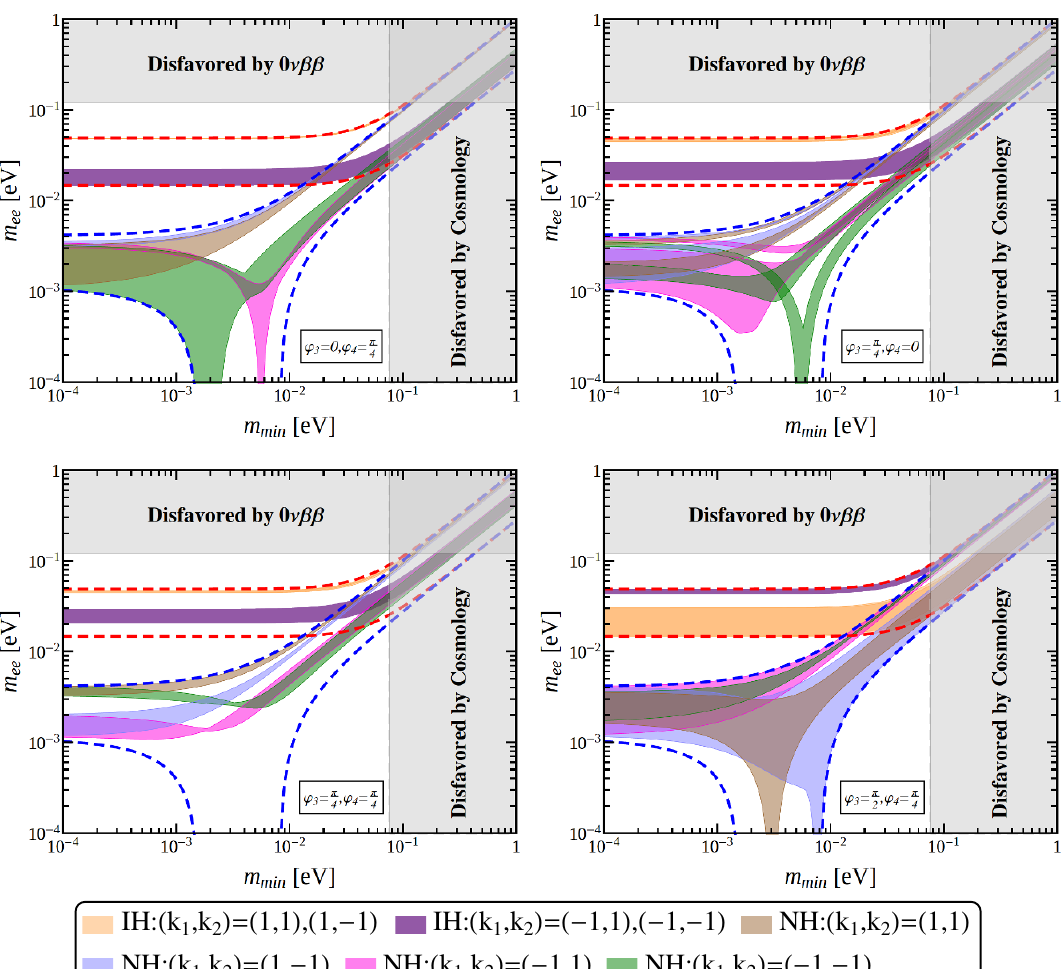
Figure 9 . The possible values of the e(cid:11)ective Majorana mass m ee as a function of the lightest L neutrino mass m min for mixing matrix U II ; 2 with n = 4. The red (blue) dashed lines indicate the most general allowed regions for IH (NH) neutrino mass spectrum obtained by varying the mixing parameters over their 3 (cid:27) ranges [8]. The present most stringent upper limits m ee < 0 : 120 eV from EXO-200 [85, 86] and KamLAND-ZEN [87] is shown by horizontal grey band. The vertical grey exclusion band denotes the current bound coming from the cosmological data of P m i < 0 : 230 eV at 95% con(cid:12)dence level obtained by the Planck collaboration